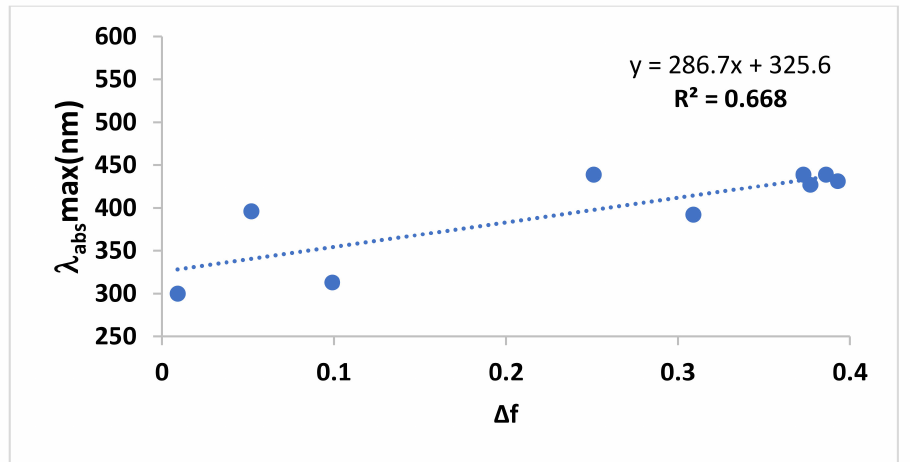
Figure 12. Effect of solvent relative polarity on λ ab max of 7.6 × 10 − 5 M of 2-amino-4-hydroxy-6- (4-hydroxy-2-oxo-2H-chromen-3-yl)nicotinonitrile 4